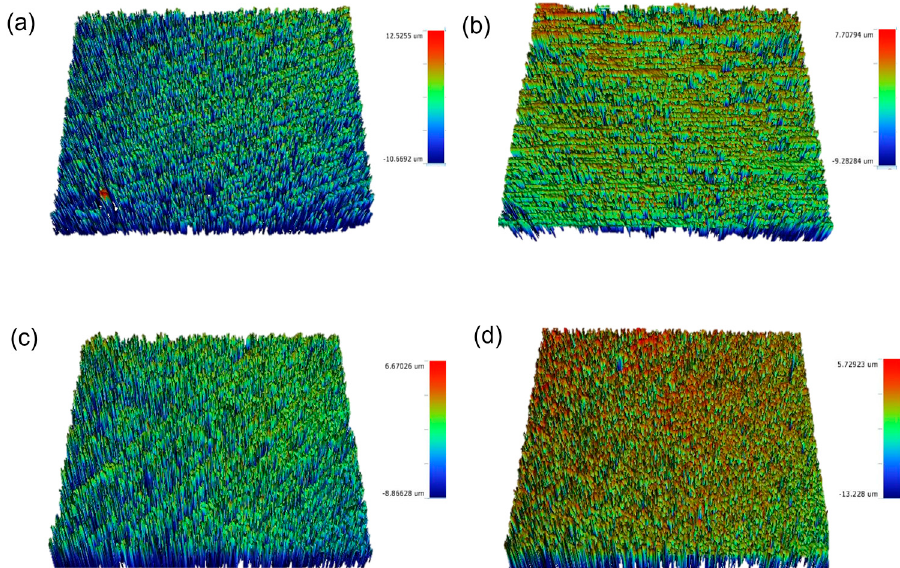
Figure 4. Surface roughness (Ra) of ultrasonic scaling of each: ( a ) CD, ( b ) CT, ( c ) IPE, and ( d ) IPS. CD; zirconia-reinforced lithium silicate (Celtra Duo). CT; advanced lithium disilicate (CEREC Tessera). IPE; lithium disilicate (IPS Emax CAD). IPS; leucite-reinforced (IPS Empress CAD).